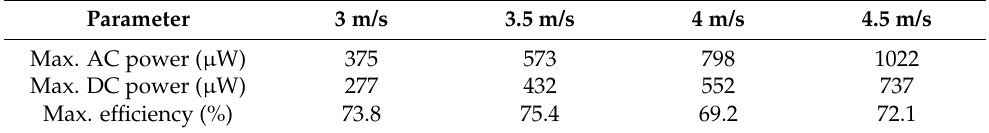
Figure 9. DC power versus resistive load while the EMWEH was operated at various wind speeds. Table 2. Summary of maximum AC power, DC power, and power efficiency for different wind speeds.